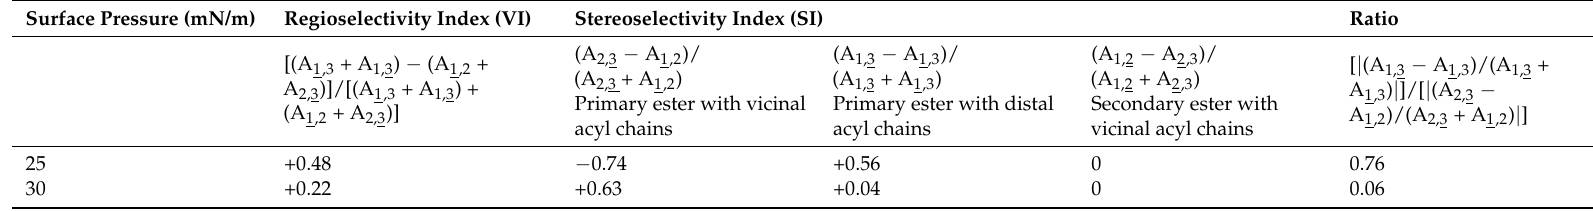
Table 3. Summary on regioselectivity index (VI) and stereoselectivity index (SI) of rGZEL on different didecanoyl glyceride